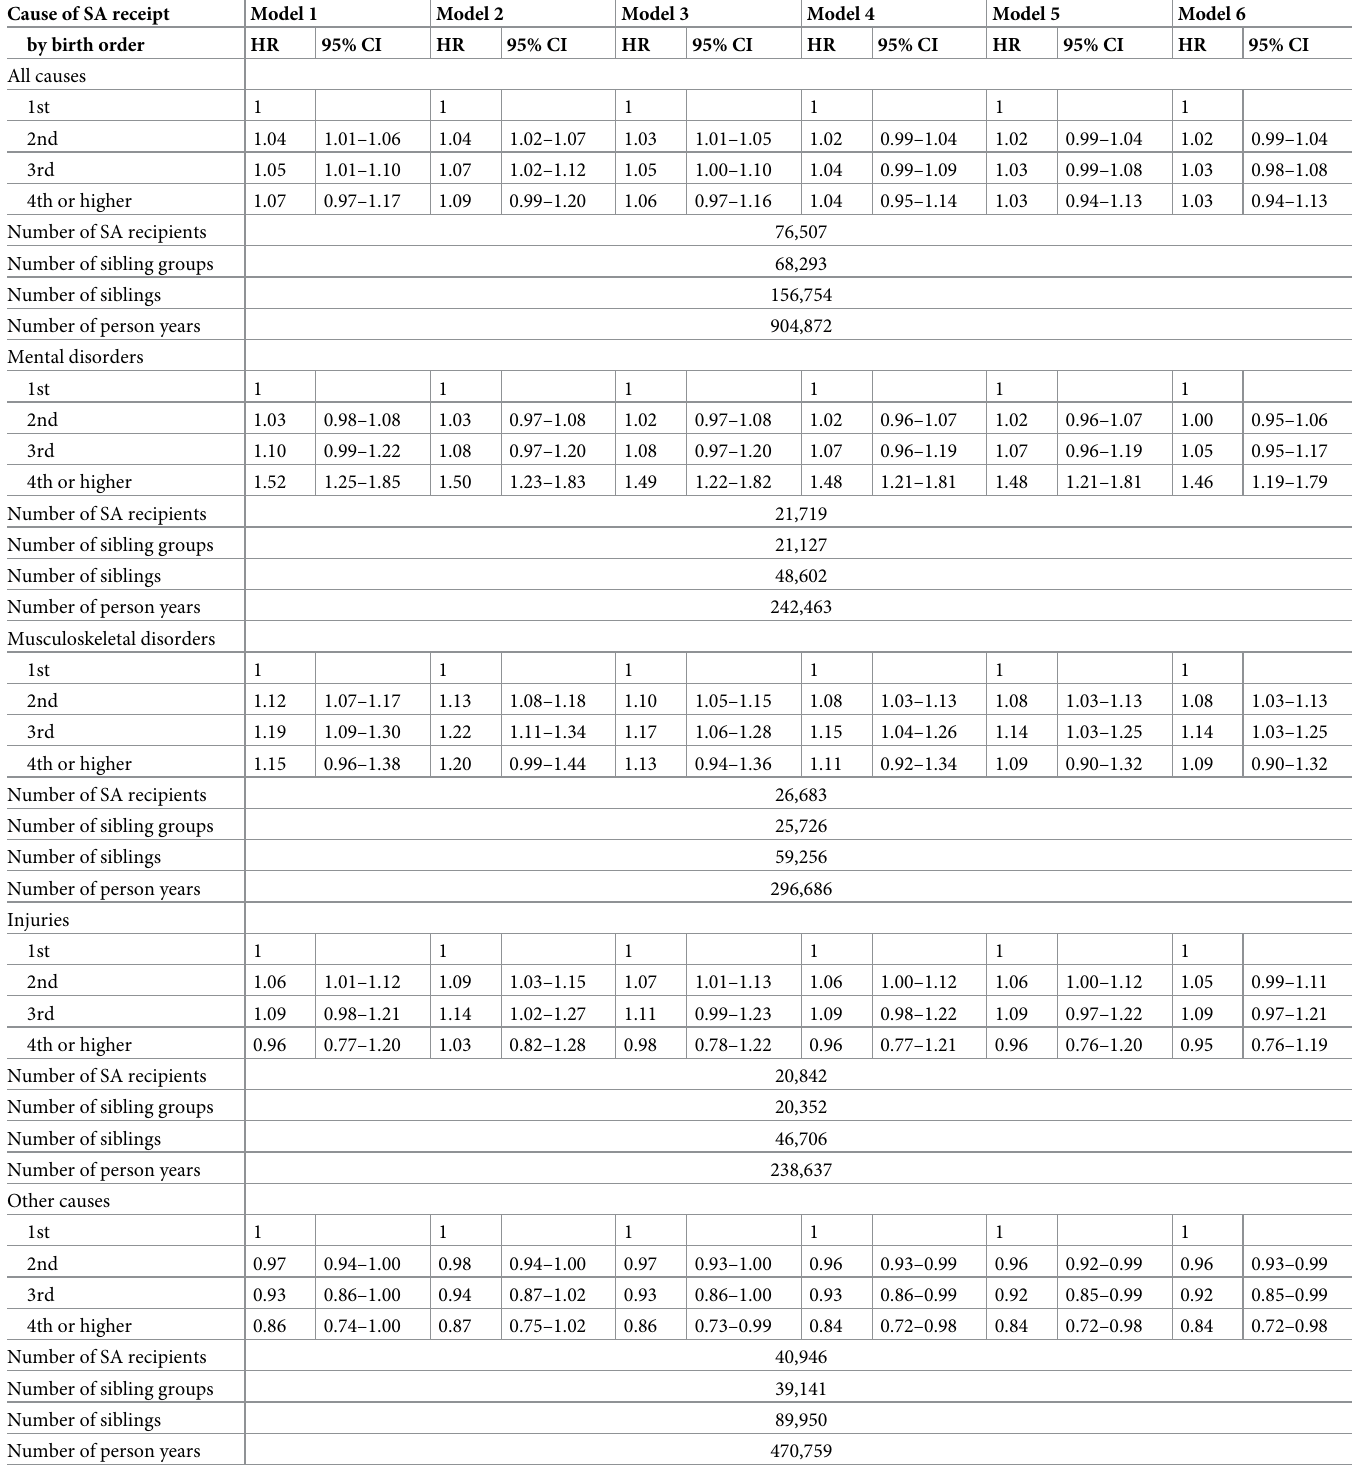
Table 2. Hazard ratios with 95% confidence intervals for estimated associations between birth order and sickness absence, results from Cox regression models strat- ified by shared mother and father